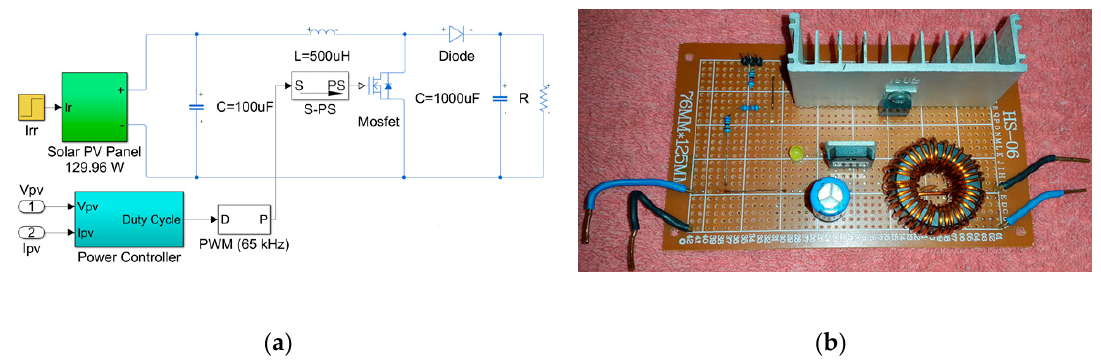
Figure 6. The model and the prototype of the boost converter: ( a ) SIMULINK model, ( b ) experimental prototype.